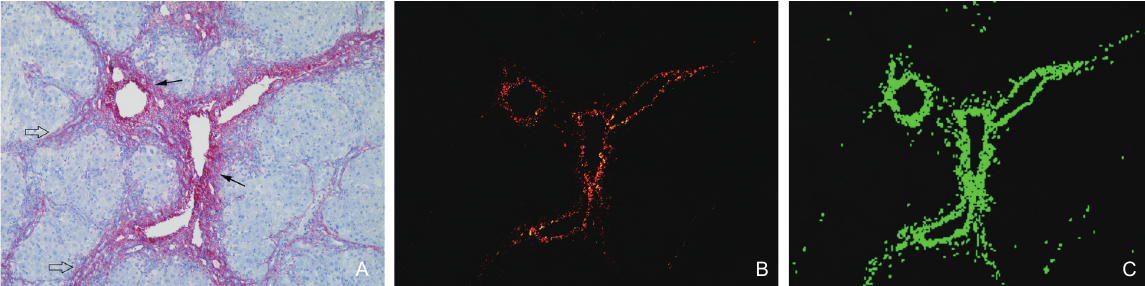
Figure 2 Picric-sirius red staining of a specimen histologically proven to be fibrosis stage 4 (A). The black arrow indicates the obviously expansile portal area and hypertrophic collagen, and the white arrow indicates the migration of hyperplastic fibrous tissue from portal area to portal area or central vein. Under polarized light, type I collagen can be visualized as yellow and red, thick, and strong double refraction, whereas type III collagen is seen as green, thin, and weak double refraction (B). Collagen in digital images was assigned the green color for further auto-calculation of collagen proportionate area (CPA)